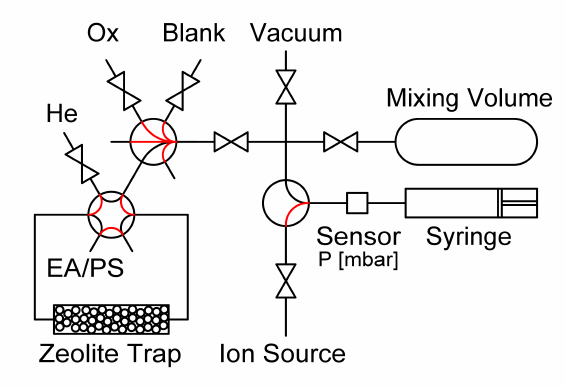
Figure 1. Dedicated gas mixing and injection system for the measurement of ( 14 C / 12 C) isotopic ratios from neutron-irradiated reactor graphite. The system can measure CO 2 from an elemental analyzer (EA) or from the graphite pretreatment system